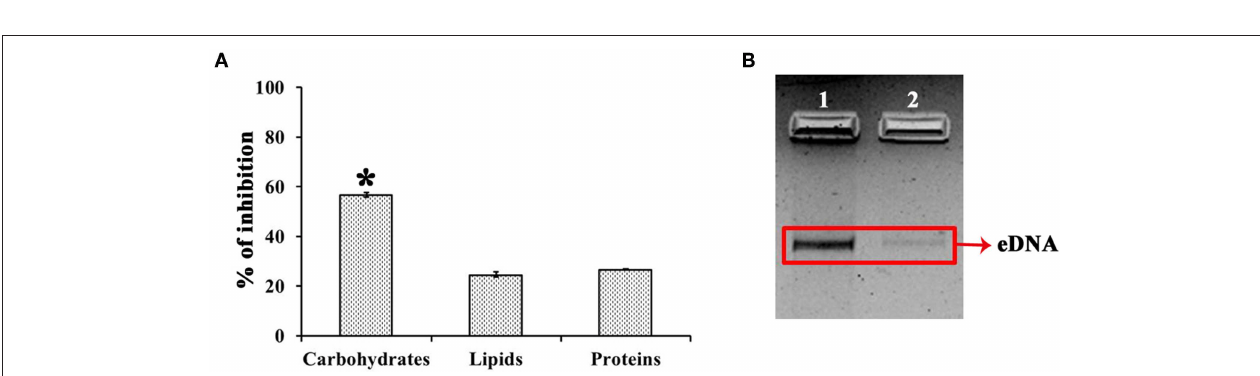
FIGURE 6 | Effect of UMB on biopolymers of biofilm matrix. (A) Bar chart depicting the percentage inhibition of carbohydrates, lipids and proteins of biofilm matrix upon UMB treatment. (B) Agarose gel image indicating the effect of UMB on eDNA content of biofilm matrix. Lane 1—MRSE control; Lane 2—MRSE treated with UMB (at 500 µ g/ml). The red box highlights the eDNA band of control and UMB treated samples. * Statistical significance between control and treated samples from three independent experiments ( p < 0.005).